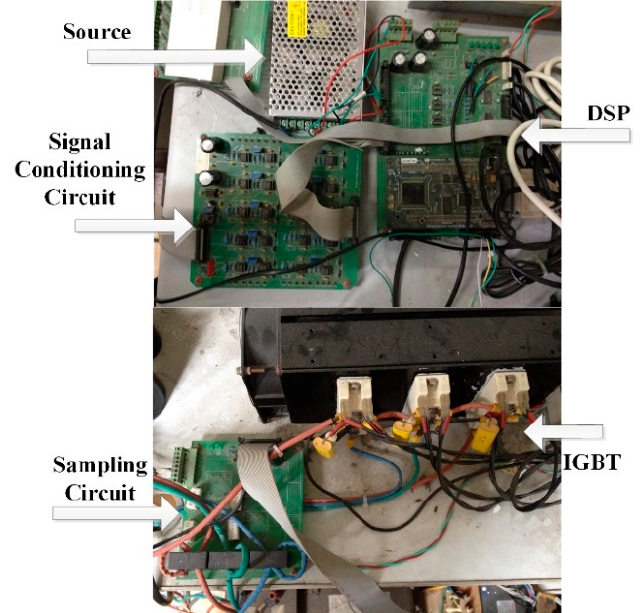
Figure 9. The experimental platform.